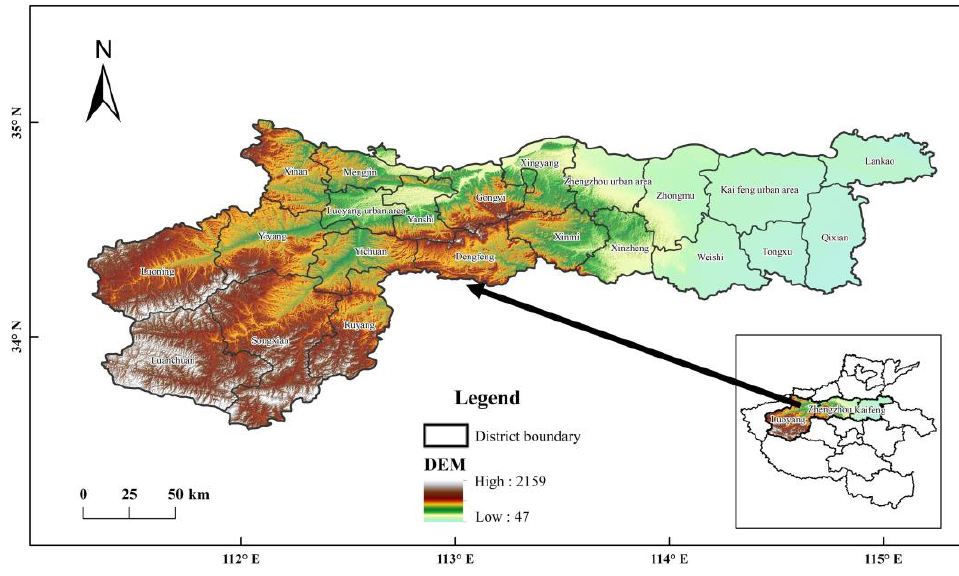
Figure 1. The profile of the study area.